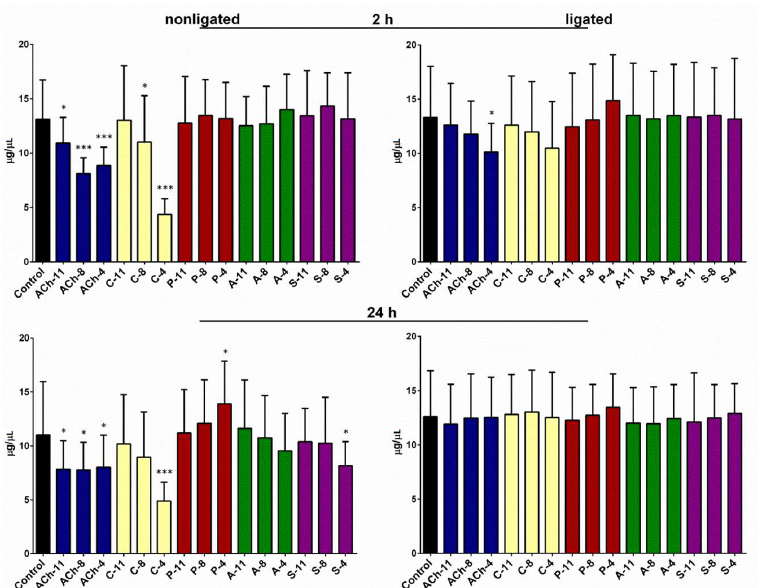
Figure 3. Free sugars concentration in the hemolymph of nonligated and neck-ligated larvae of T. molitor beetles injected with acetylcholine (ACh), carbachol (C), pilocarpine (P), atropine (A), and scopolamine (S) at concentrations of 10 − 11 (X-11), 10 − 8 (X-8), and 10 − 4 M (X-4) for each compound. The samples were isolated after 2 and 24 h of incubation. The control larvae were treated with saline. Mean values ± SD are given from at least 15 determinations. Statistically significant differences of the test values from the control values are indicated by asterisks (Student’s t -test), where * p ≤ 0.05 and *** p ≤ 0.001.